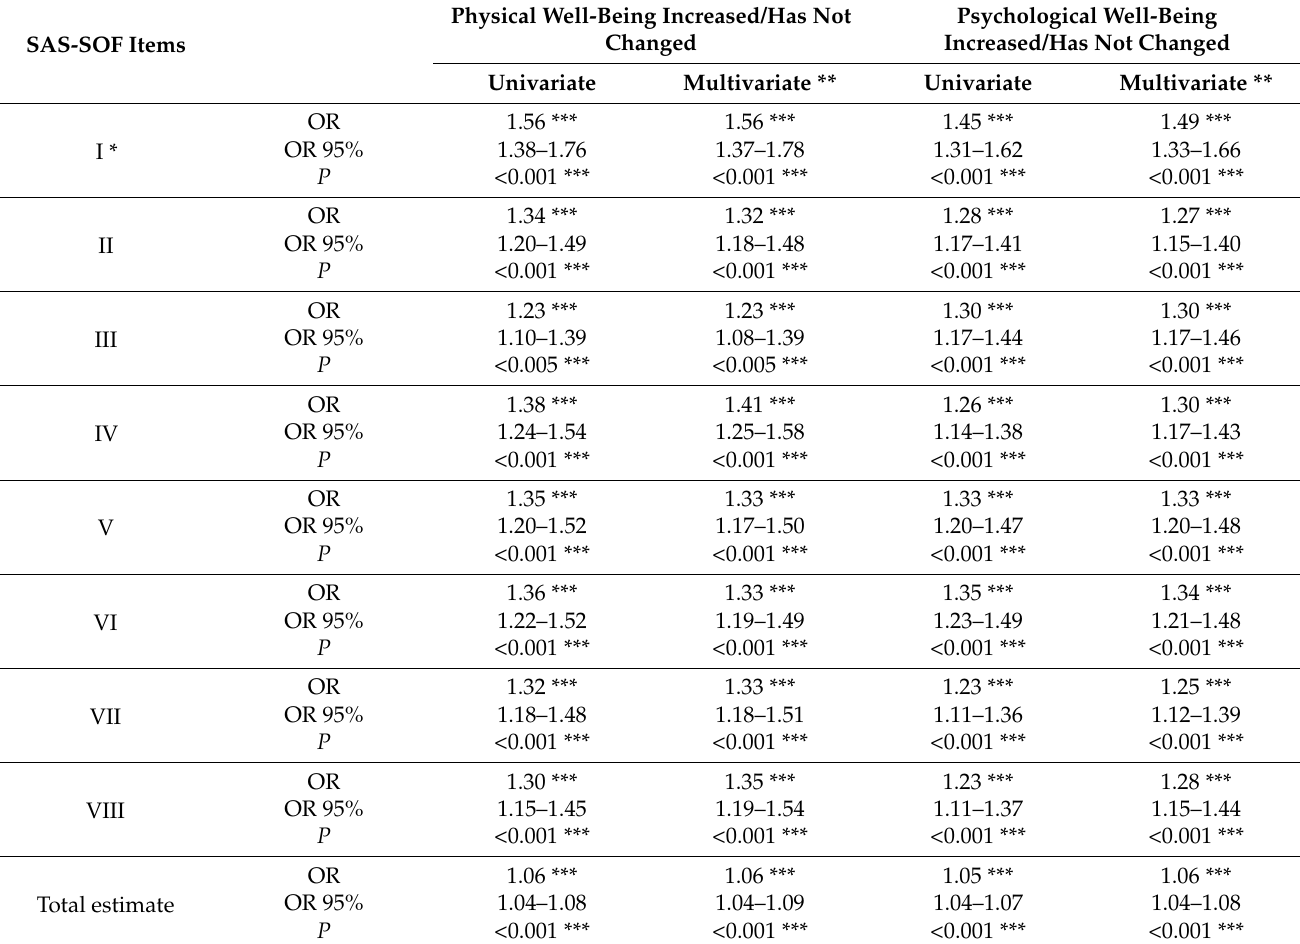
* The SAS-SOF statements group numbers correspond to the numbers of these statements and the corresponding statement formulations in Table 1. ** Controlled indicators in multivariate analyses—gender, age, workplace, position. *** These variables showed statistical